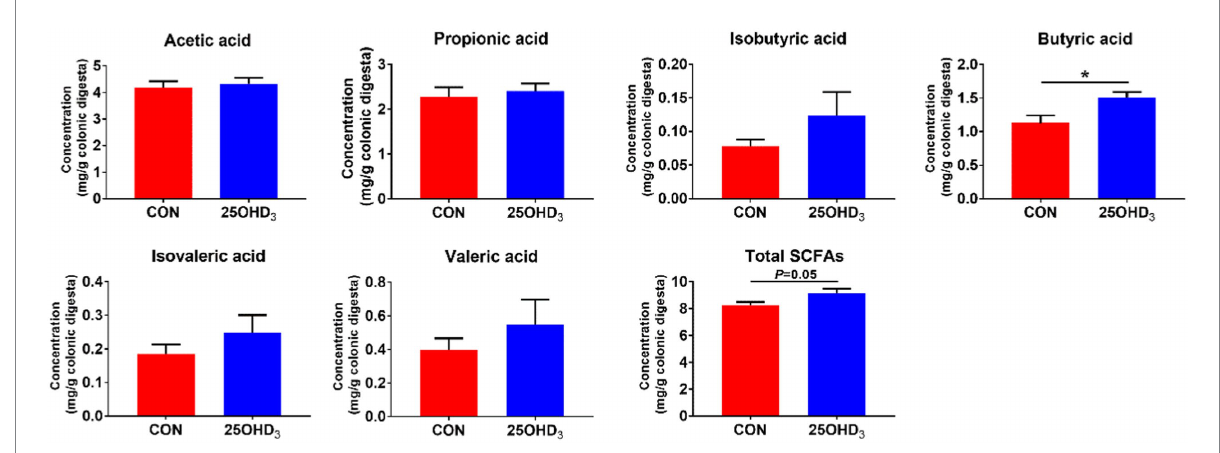
FIGURE 7 The concentrations of SCFAs in the colonic digesta. Values are shown as the means ± SEM, n = 5. * p < 0.05 versus CON group.